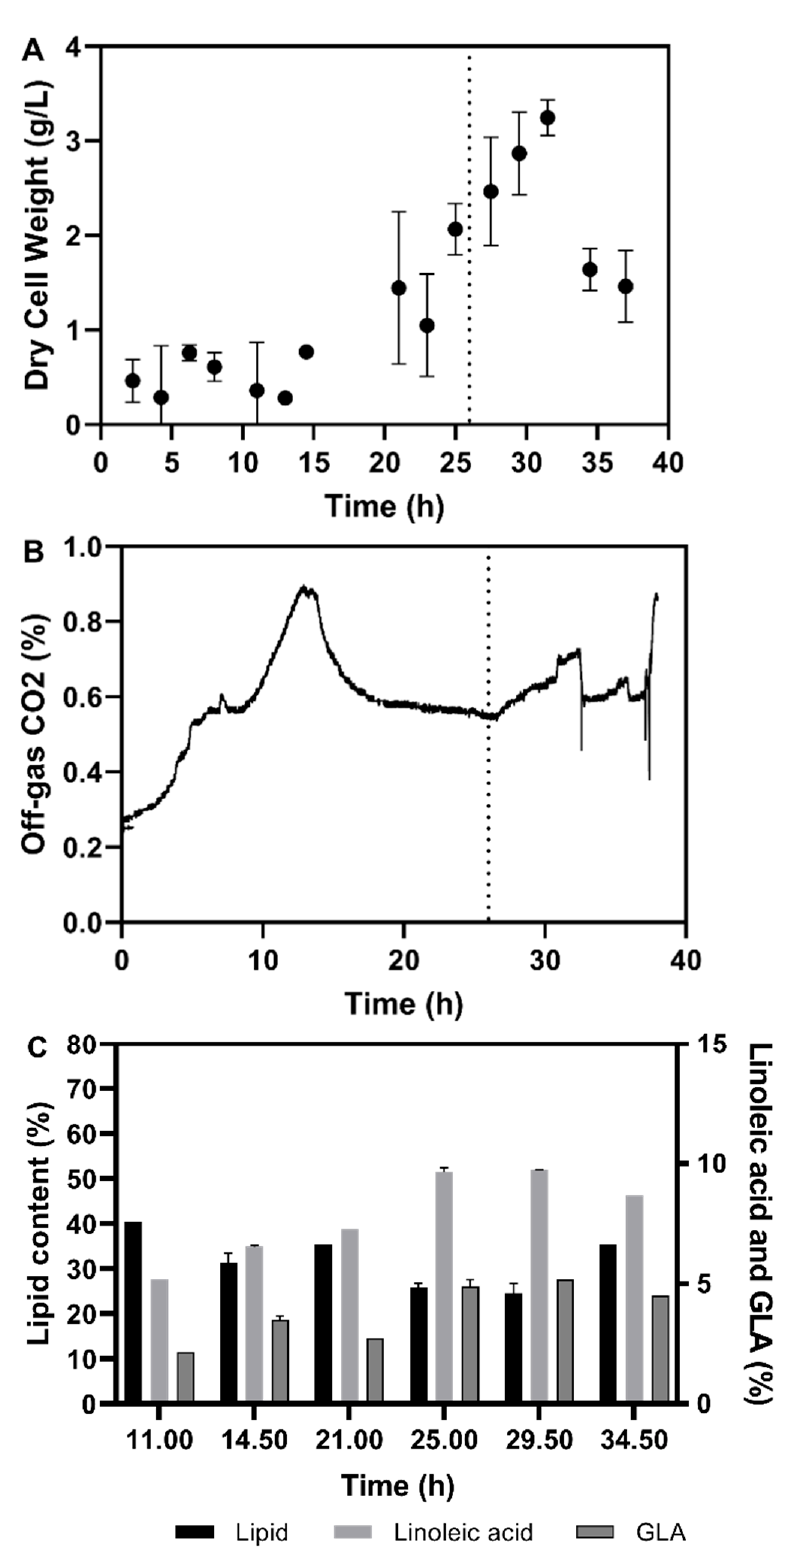
Figure 7. ( A ) Dry cell weight, ( B ) off-gas CO 2 profile, and ( C ) total lipid content (% wt of dry cell weight), linoleic acid, and GLA (% wt of total lipid weight) obtained during fed-batch cultivation of M. circinelloides in fermenter using animal fat rest materials. The dotted vertical line indicates the beginning of feed phase.